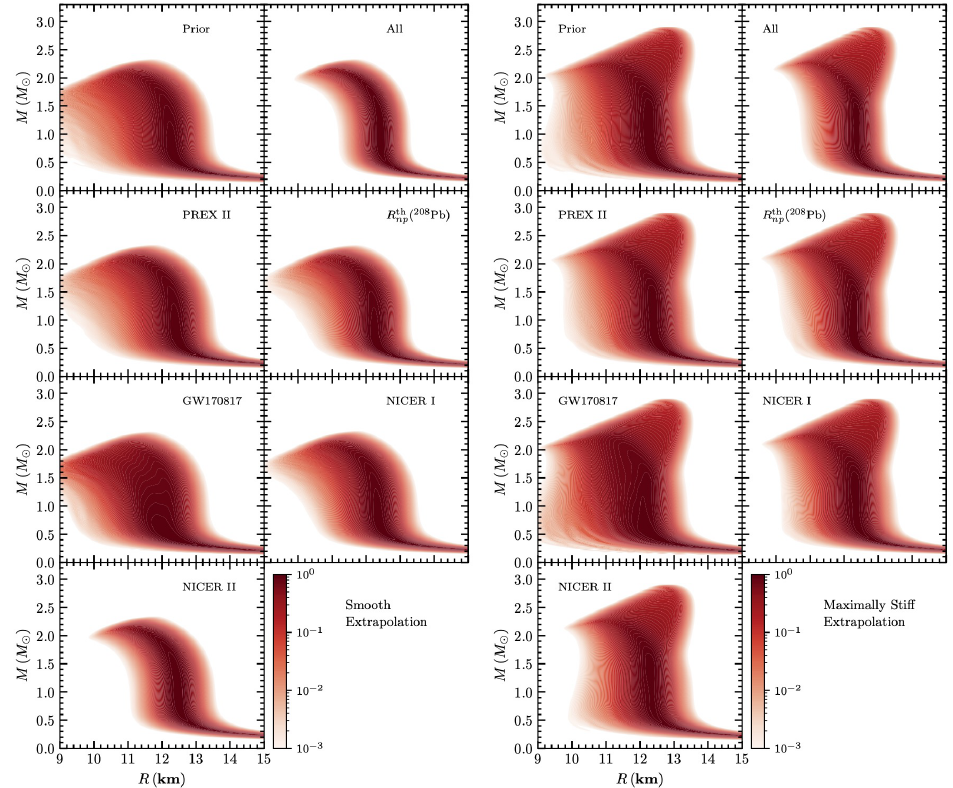
Figure 3. The mass-radius probability densities (priors, individual posteriors, and combined pos- teriors) from the smooth high-density extrapolation ( left ) and the maximally-stiff high-density extrapolation ( right ) energy density